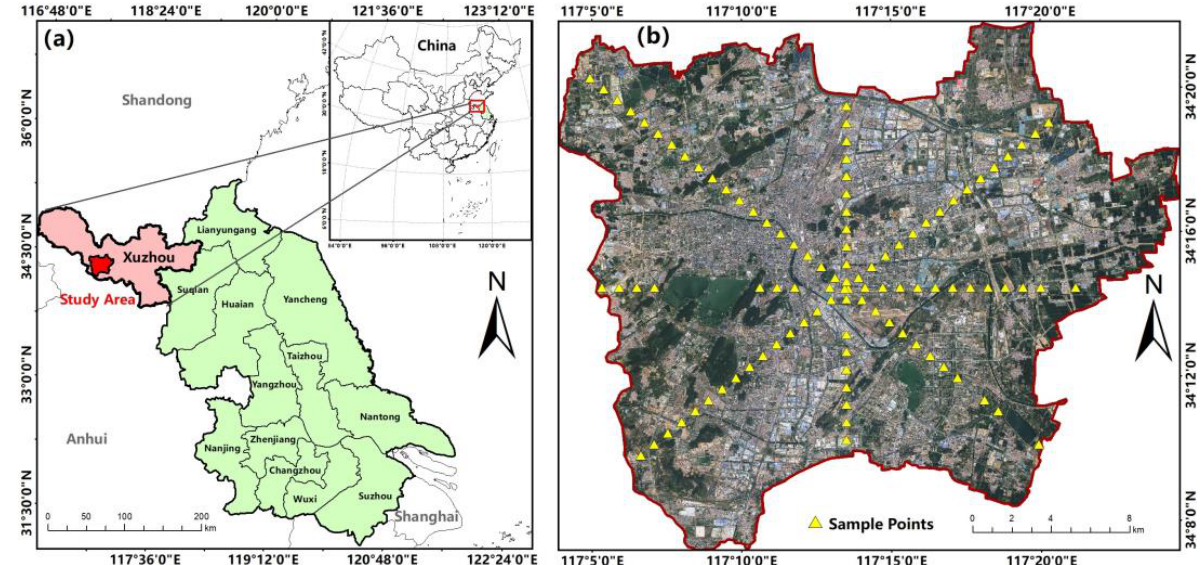
Figure 1. Maps of the study area: ( a ) Location of the study area in Jiangsu province, China; ( b ) GF- 1 satellite image of the study area (acquired on 28 April 2020).